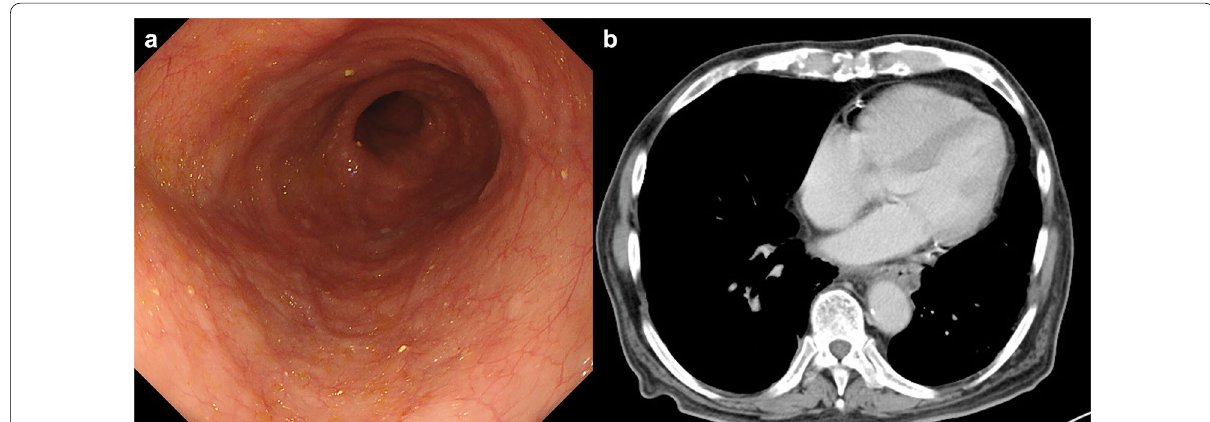
Fig. 4 Postoperative findings. a Upper endoscopy image of the lower-thoracic esophagus taken 2 months post-surgery showing no sign of esophageal stricture or malignant mucosal invasion. b Contrast enhanced computed tomography of the chest taken 10 months post-surgery showing no sign of disease